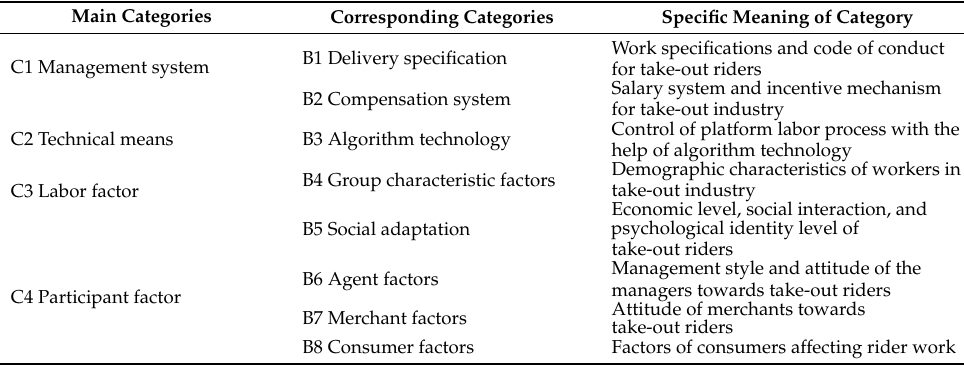
Table 6. Selective coding for interview